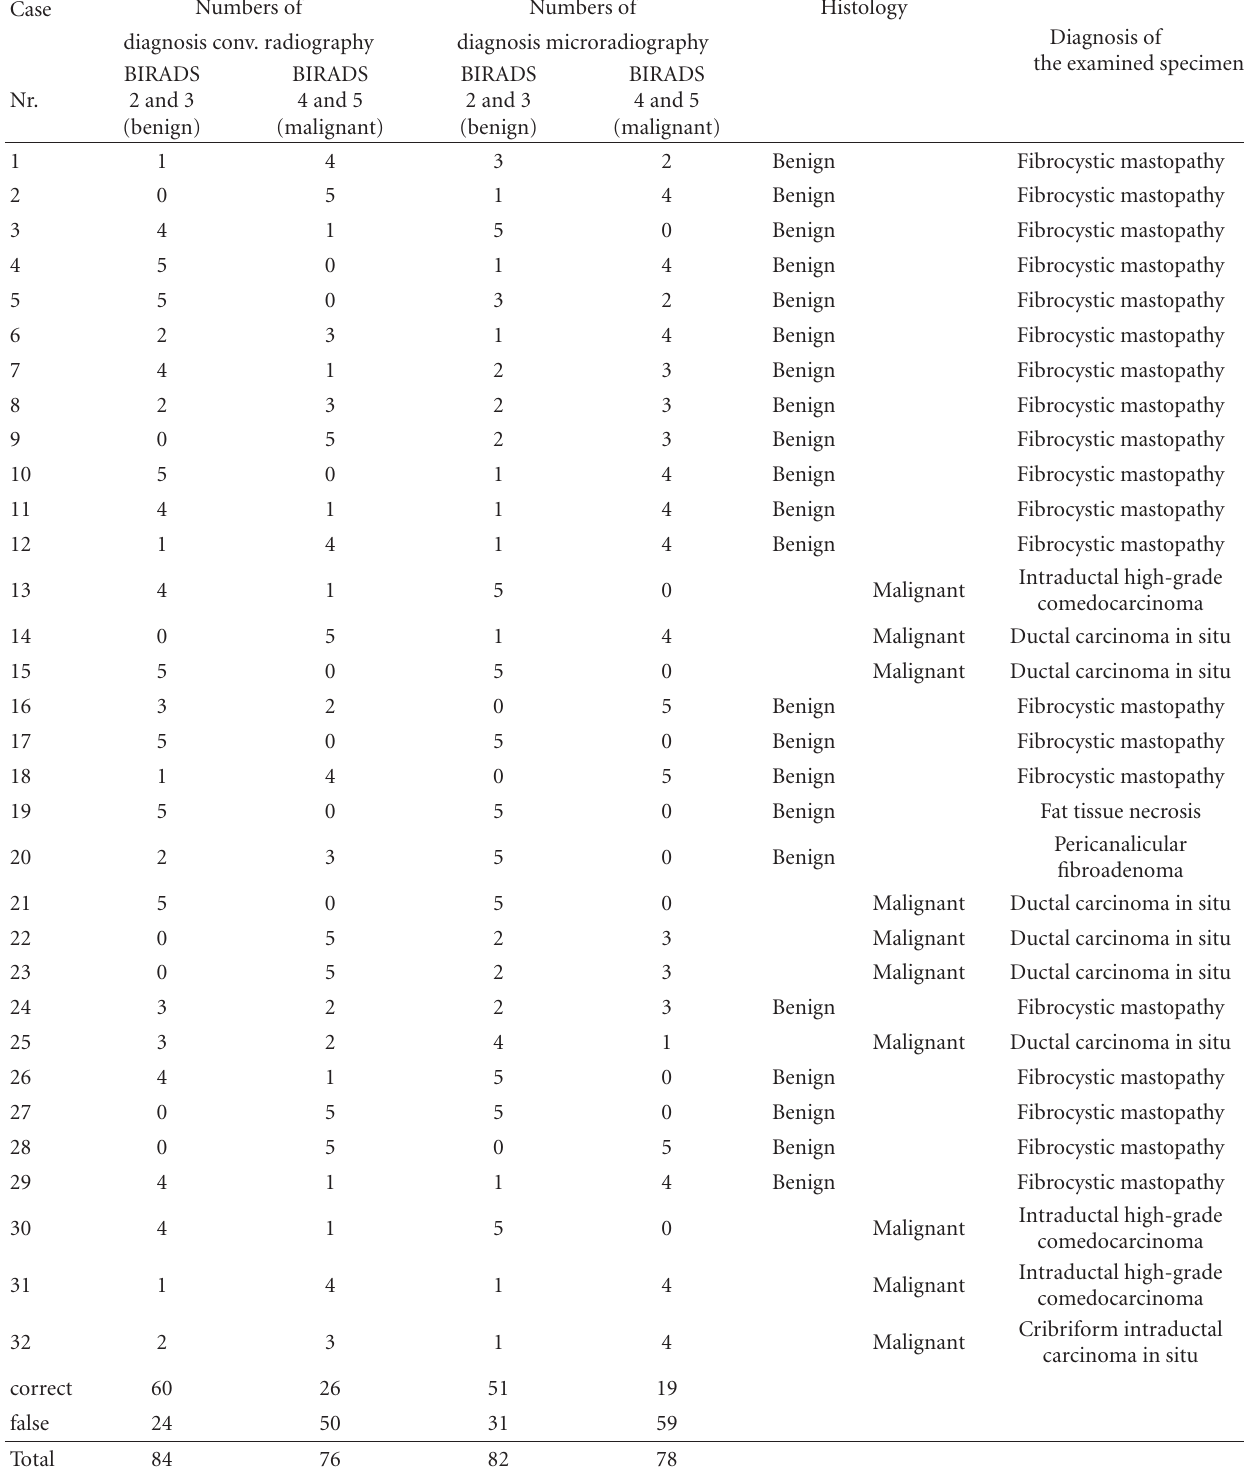
Table 2: BIRADS classification in conventional specimen radiography and microradiography. Summary of five examiners. Case Numbers of Numbers of Histology specimendiagnosis conv.